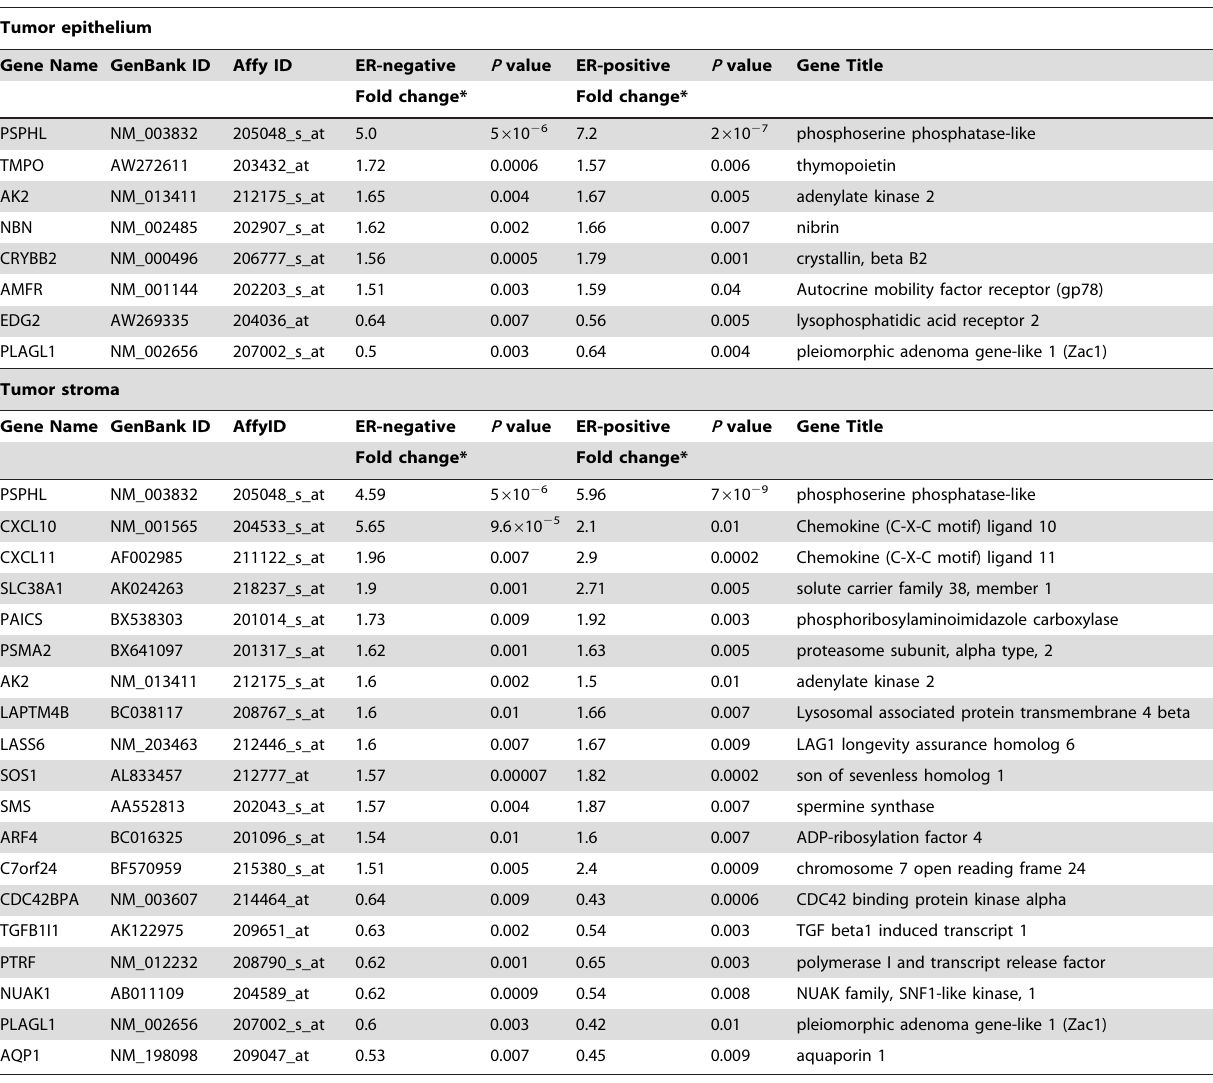
Table 3. Most differently expressed genes by race/ethnicity independent of the tumor ER status.